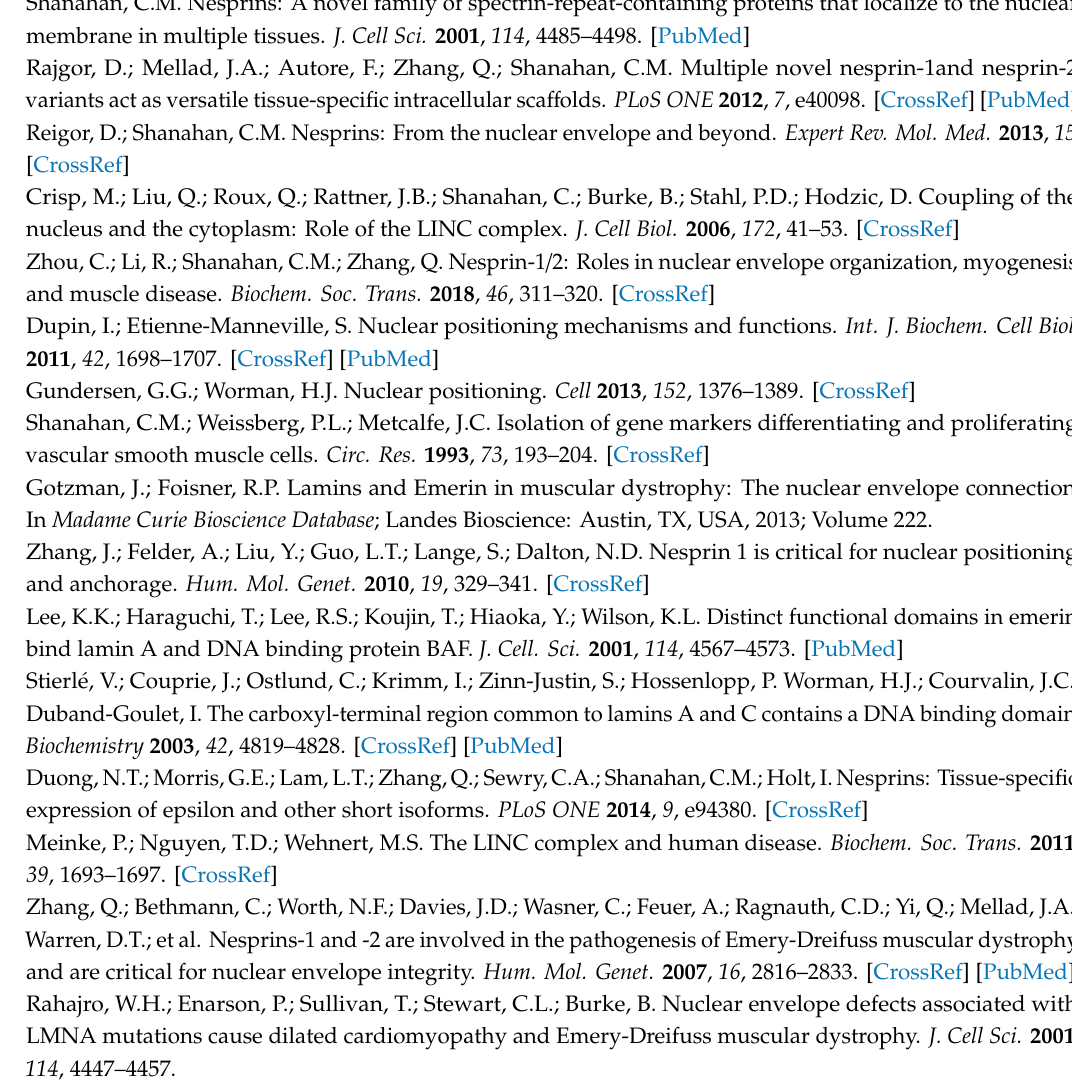
24 h following irradiation with the dose of 8 Gy of γ -rays; Figure S2C: Examples of SUN2, nesprin-1, SUN2 and LA / C mislocalization in MCF-LBR(-) and U2OS-LBR(-) 24 h following irradiation with the dose of 8 Gy of γ -rays; Figure S3: Western blot analysis of LBR, SUN2, and nesprin-1 expression in control and LBR-deficient MCF7 and U2OS